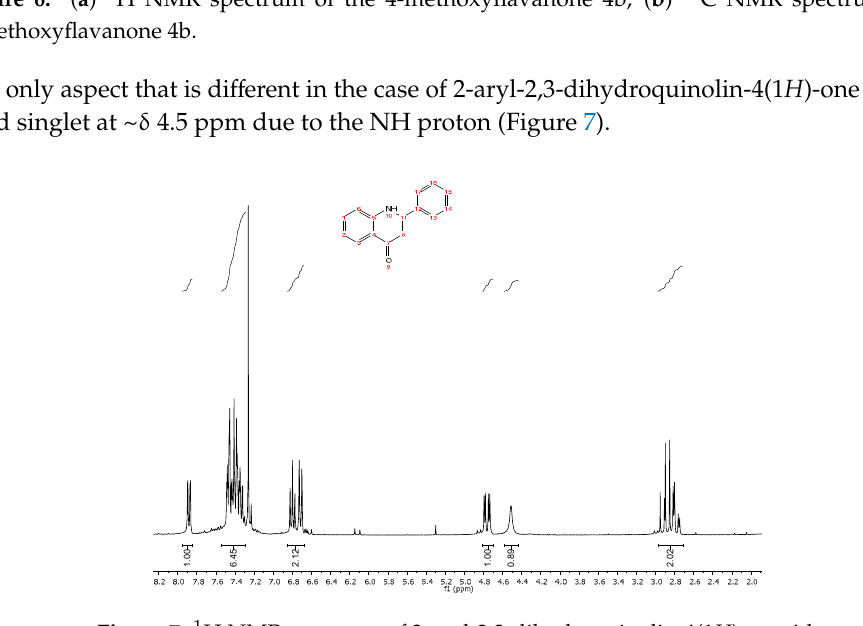
Figure 7. 1 H NMR spectrum of 2-aryl-2,3-dihydroquinolin-4(1 H )-one 4d.